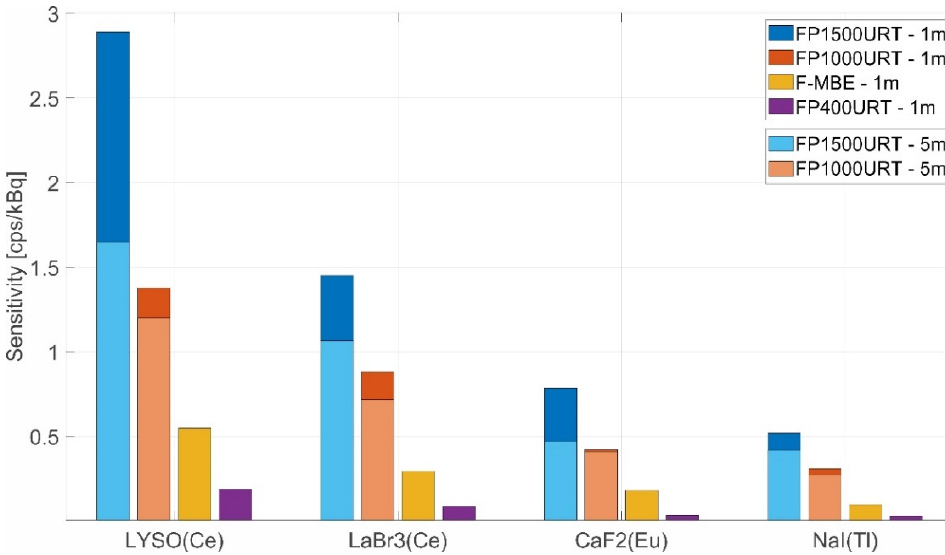
Figure 10. Different conversion efficiencies of ionising gamma rays— 60 Co in different scintillation materials in conjunction with other types of optical fibres and their different lengths.